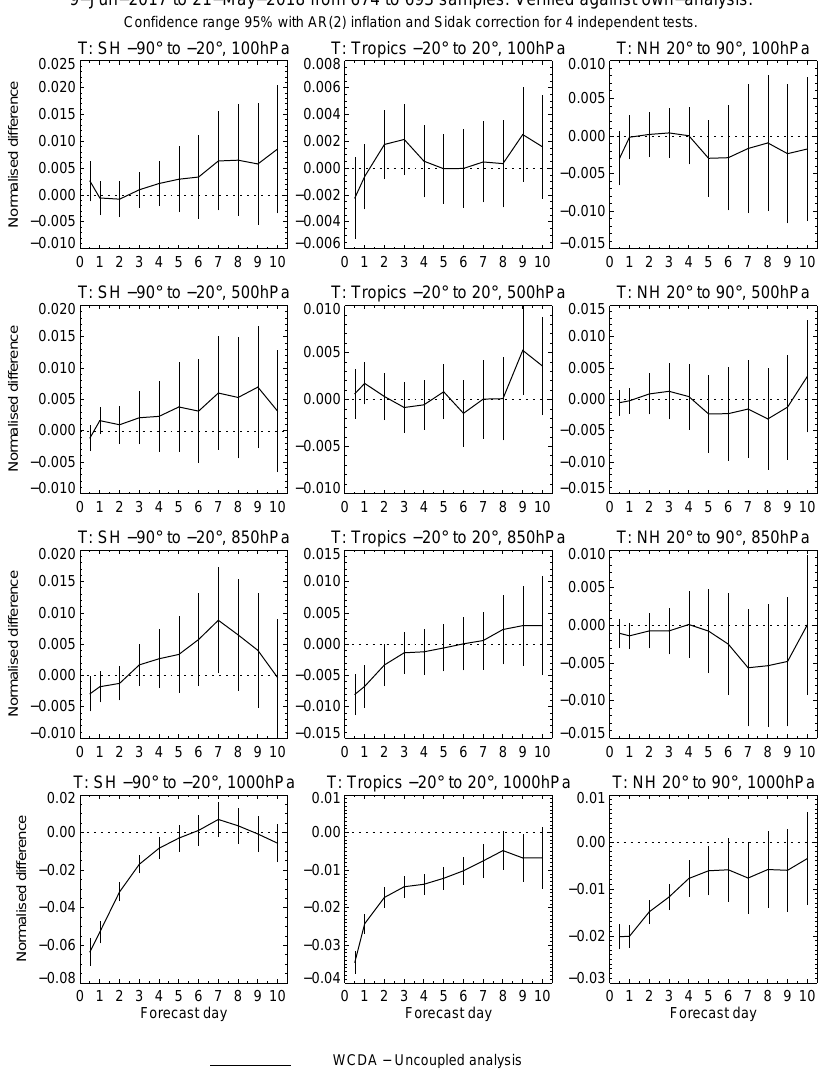
Figure A5. As Figure A4 but for atmospheric temperature. Figure A5. As in Figure A4 but for atmospheric